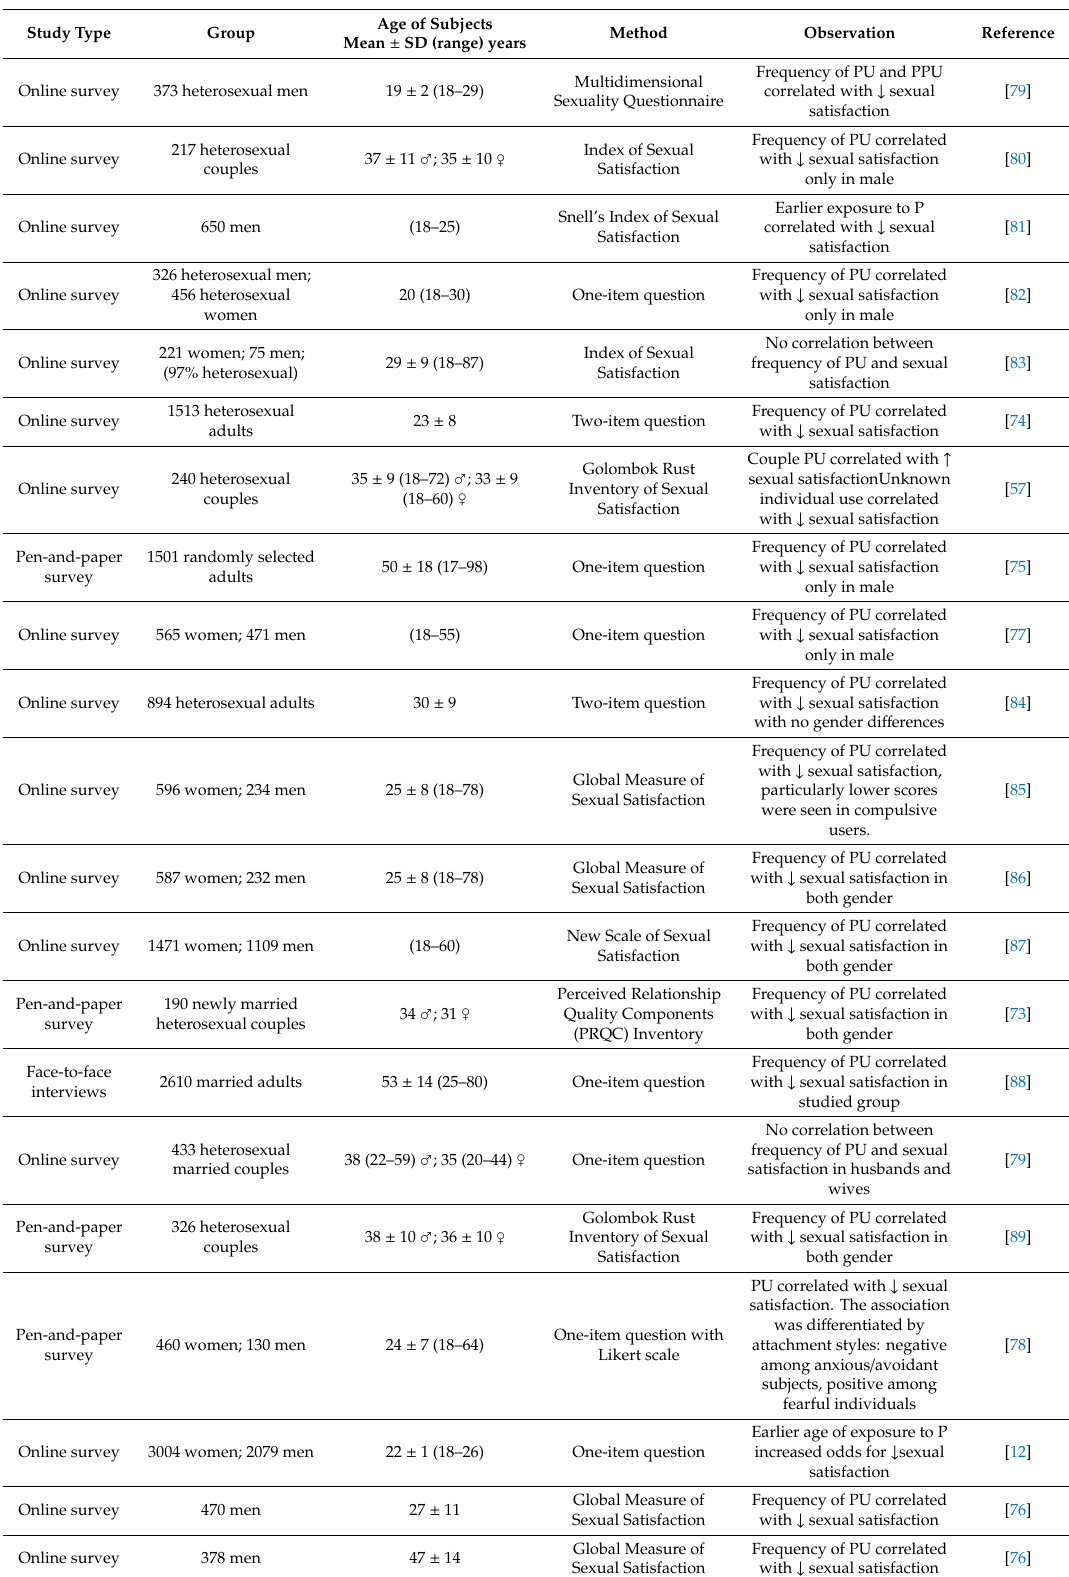
Table 1. Cross-sectional studies on association between pornography use and sexual satisfaction in women and